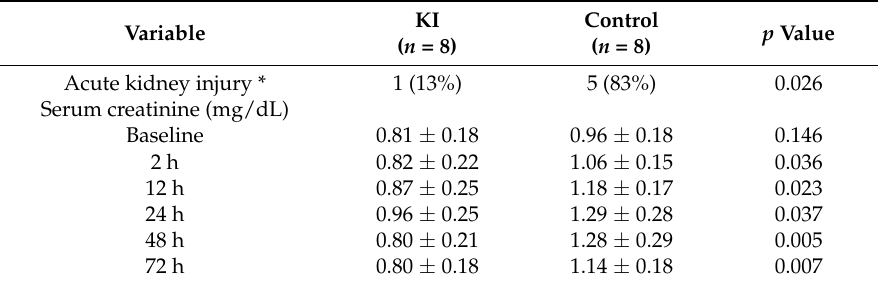
Table 2. Acute kidney injury and serum